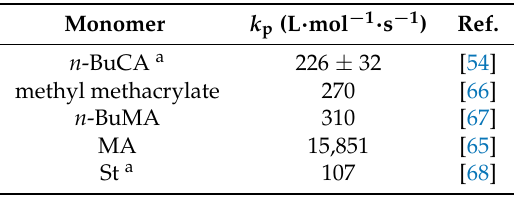
Table 4. k p values using the pulsed-laser polymerization coupled with size exclusion chromatography (PLP-SEC) method of n -butyl cyanoacrylate at 30 ◦ C and critically evaluated k p values of common vinyl monomers at 20 ◦